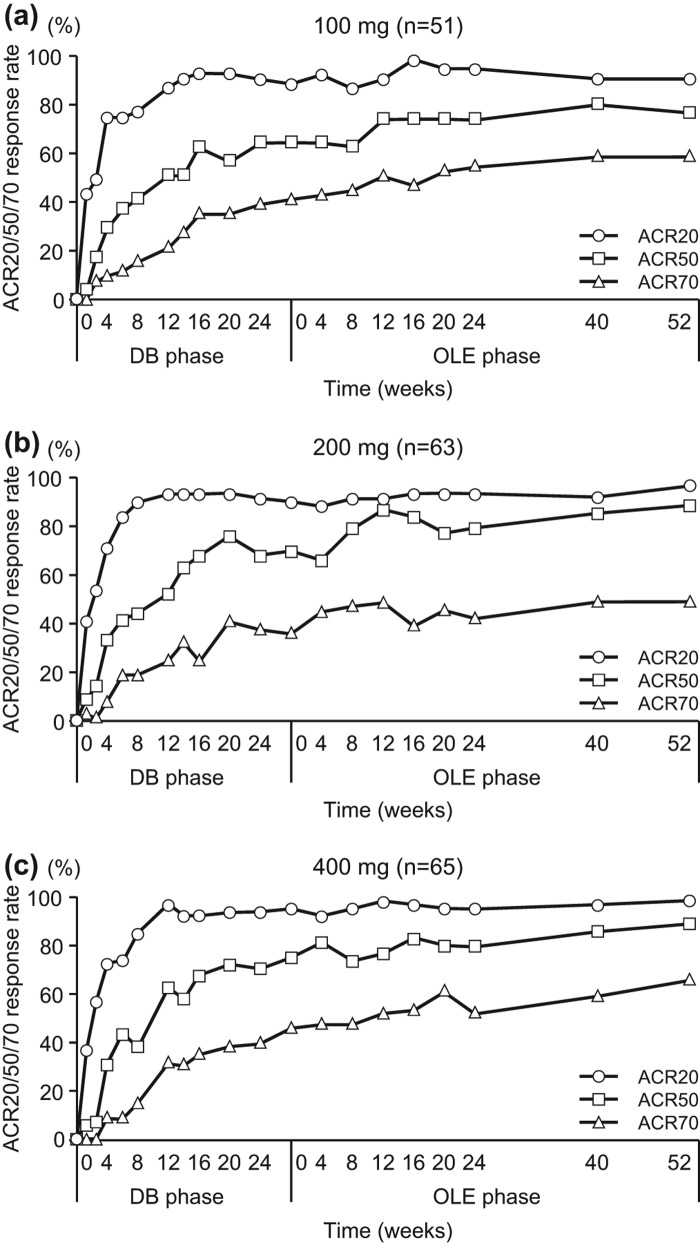
Post-hoc analysis of ACR20/ACR50/ACR70 response rates in patients from Groups II, III and IV excluding those who were in the placebo group during the DB phase (CZP-DB completers). The ACR20, ACR50 and ACR70 response rates of post-hoc analysis patients treated with (a) 100 mg (n = 51), (b) 200 mg (n = 63) or (c) 400 mg (n = 65) of CZP during the DB phase were plotted against time for the DB and the OLE phase of the study (LOCF imputation).